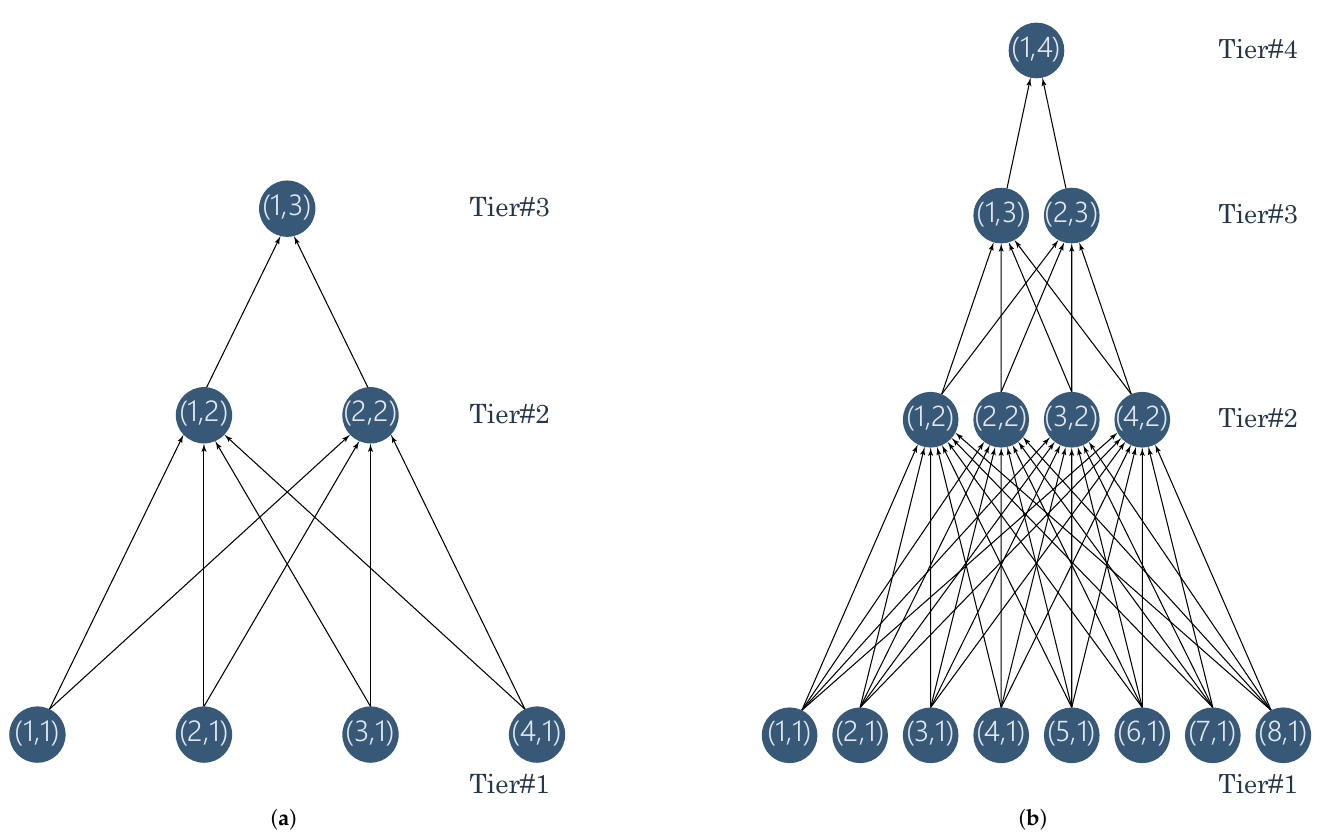
Figure 8. The considered two test topologies: ( a ) topology T 1 and ( b ) topology T